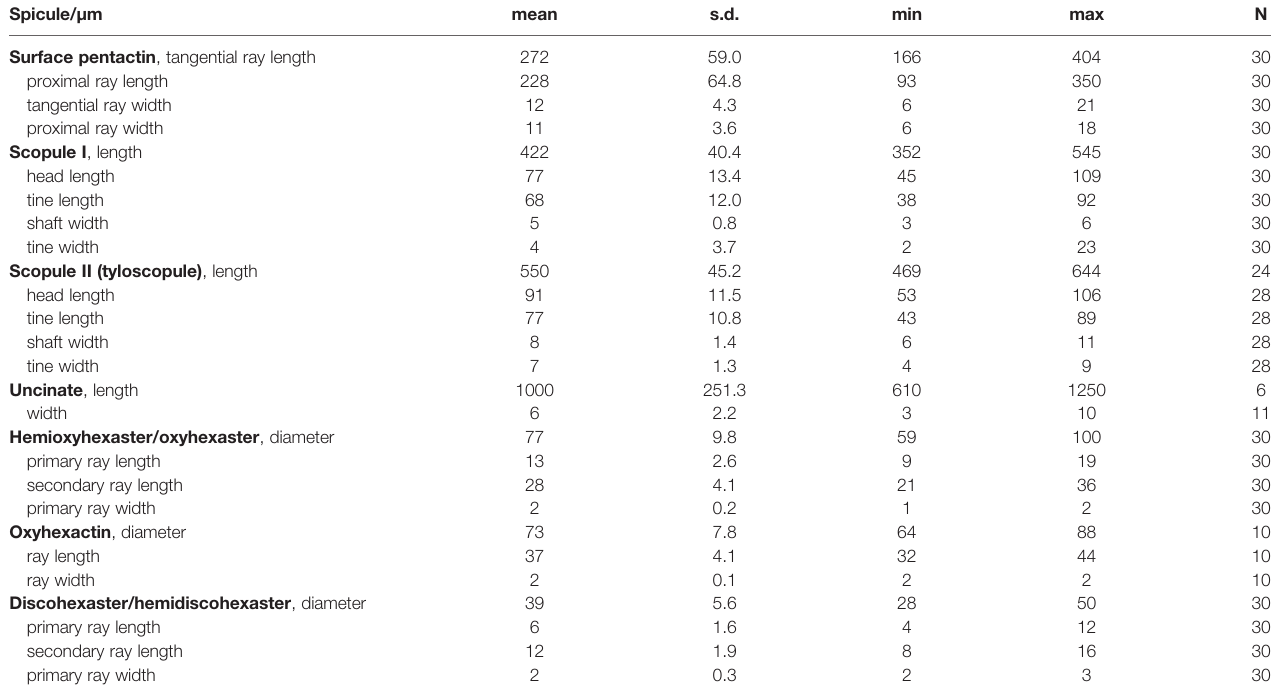
TABLE 2 | Spicule dimensions of Chonelasma tyloscopulatum sp. nov., holotype (in µm).